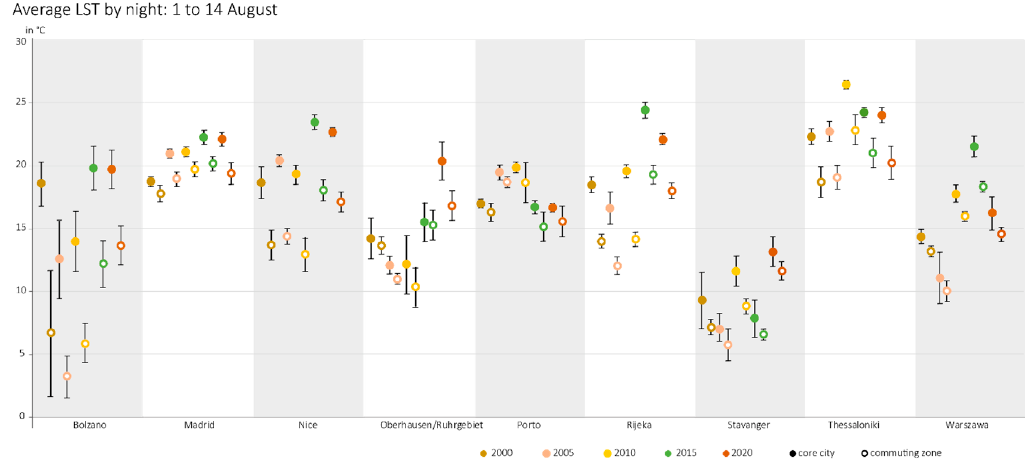
Figure 5. Average LST by night: 1 to 14 August in selected FUAs and years.